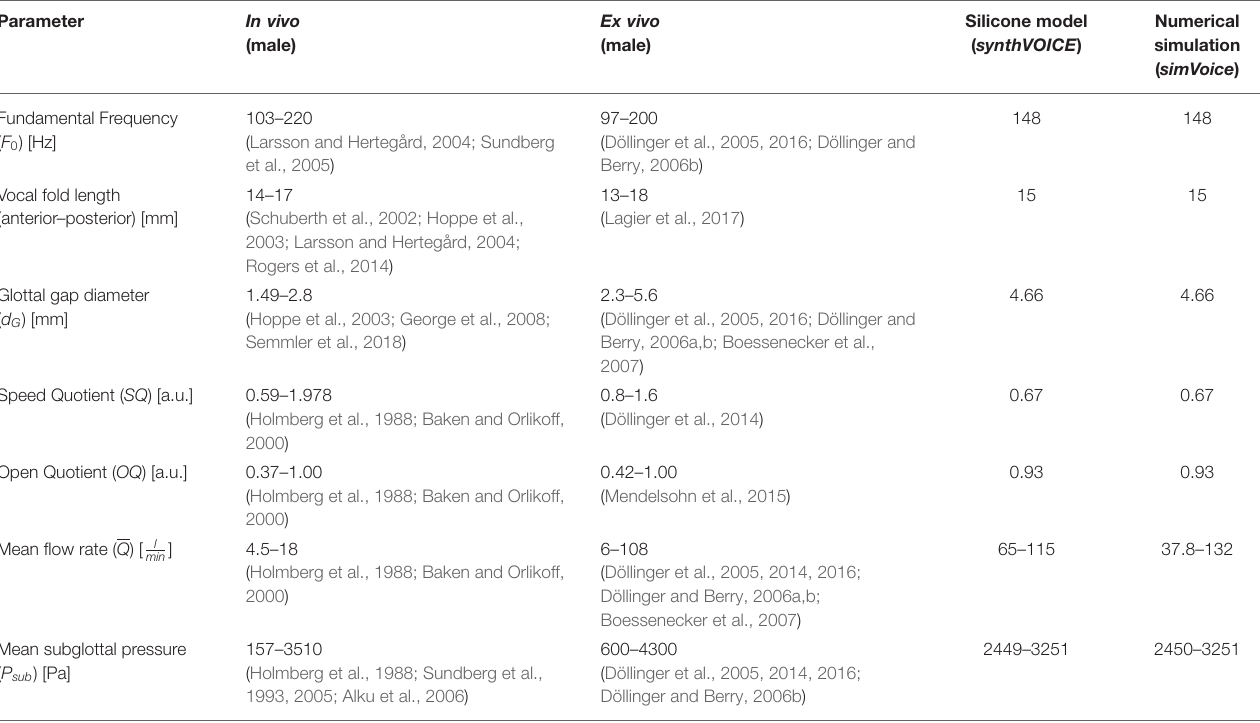
TABLE 1 | Parameter reported for normal male phonation in in vivo and ex vivo studies compared with the experimental silicone model synthVOICE (Kniesburges et al., 2013, 2016, 2020; Kniesburges, 2014) (validation cases) and the performed numerical validation simulations by simVoice (Sadeghi et al., 2018, 2019a,b; Sadeghi, 2019; Schoder et al.,